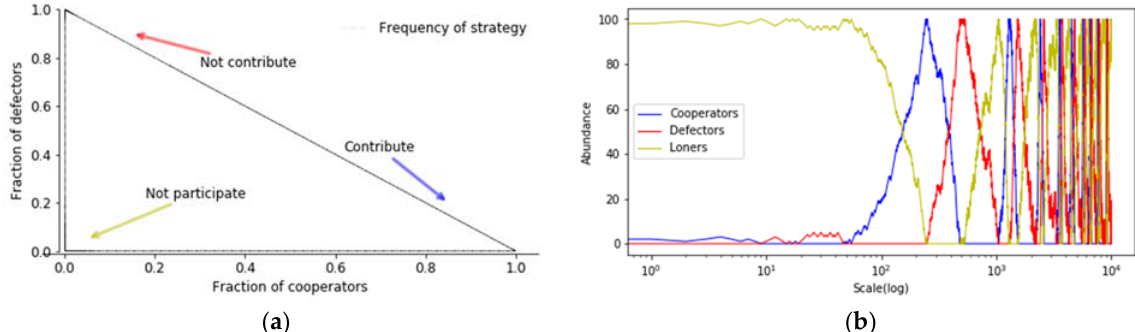
Figure 2. Simulation 1 (prototype) with replicator dynamics: ( a ) the plot on the left side shows a well-mixed population with a finite number of strategies (cooperators: blue arrow, defectors: red arrow, loners: yellow arrow) with incentive. ( b ) The parameters are N = 5, c = 1, and g = 0.5, and the interest rate is r = 3 (see Tables 2–4 for more detail regarding the parameters). The plot on the right side shows the categorized oscillation of strategies (cooperators = blue, defectors = red, loners = yellow). Table 2. Strategies of potential players (C: cooperation; D: defection; L: no participation). Definition